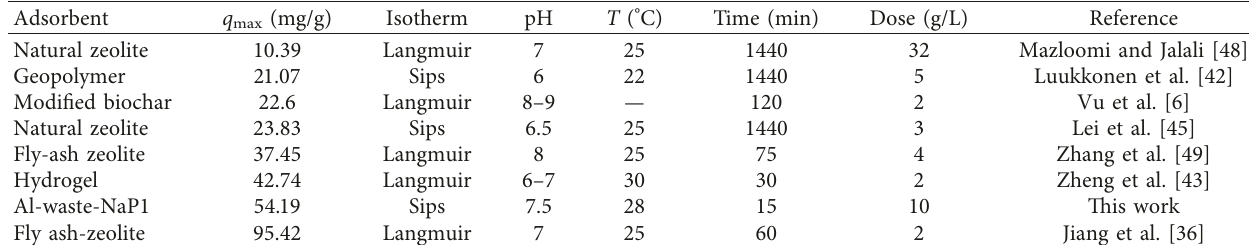
Table 3: Ammonium adsorption capacity for several